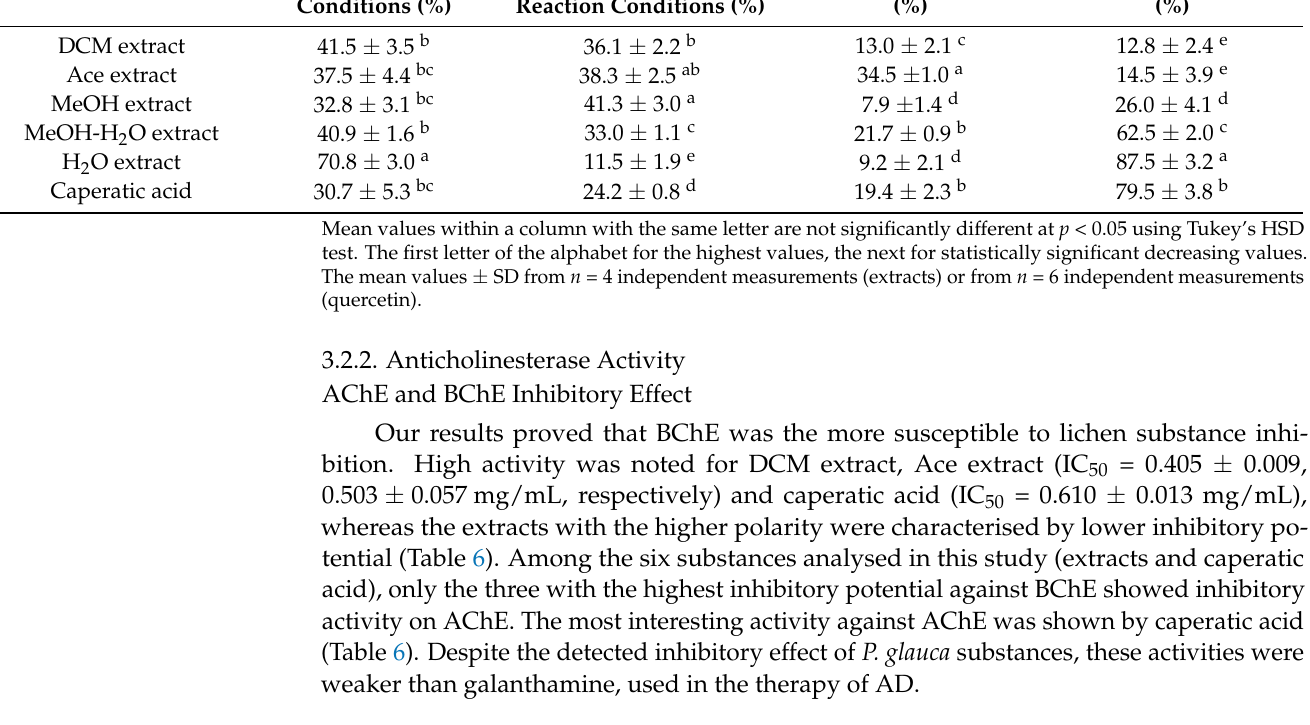
Table 6. Inhibition of AChE and BChE by lichen extracts and caperatic